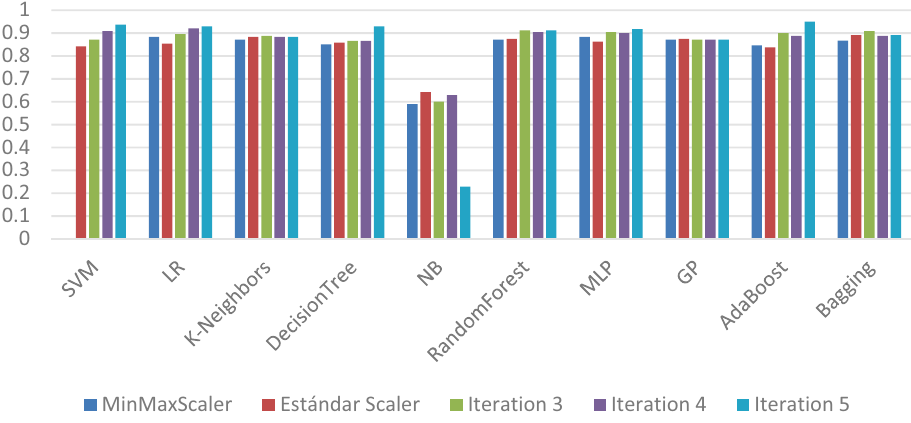
Figure 5. Accuracy obtained in each of the iterations of stratified k-fold cross validation with k = 5 on each of the algorithms used to obtain the best algorithm that works best a priori for the use